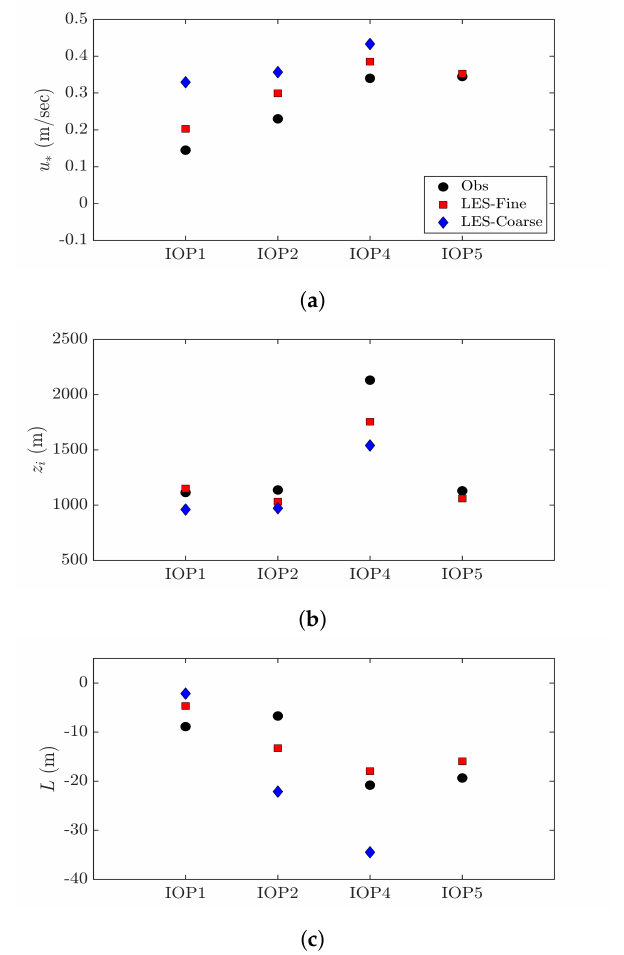
Figure 5. Comparison of 2.5-h averaged ( a ) friction velocity ( u ∗ ), ( b ) PBL height ( z i ), and ( c ) Monin–Obukhov length ( L ) between the observed values and values calculated from coarse- and fine-LES at GRI tower. The PBL height observed values were averaged from the before and after radiosonde balloon flights released during the experiments; for more information on Radiosonde launches refer to